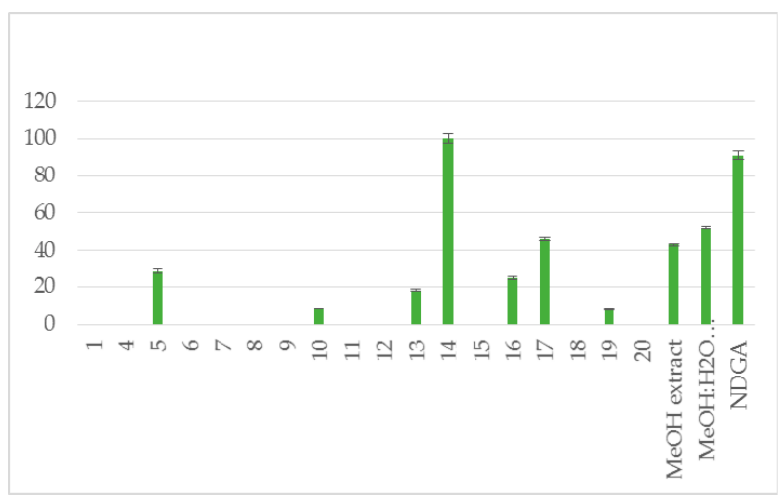
Figure 3. % Inhibition of soybean lipoxygenase (LOX) at 0.1 mM.